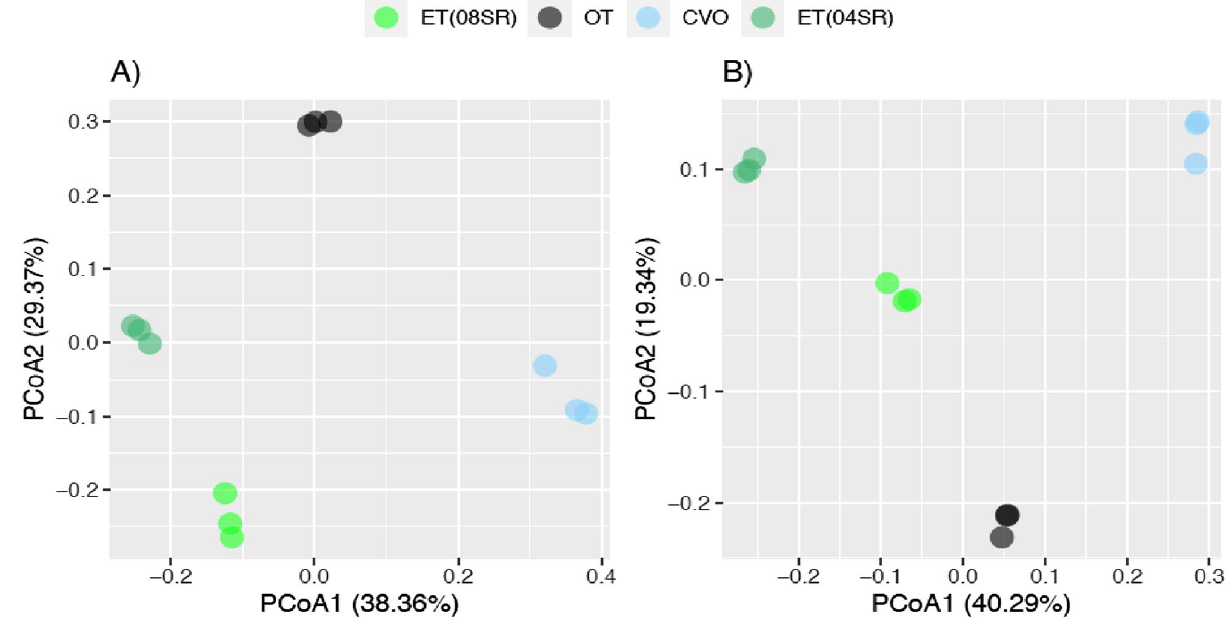
Figure 1. The Principal Coordinates Analysis (PCoA) of shallow alkaline lakes. The letter ( A ) corresponds to the dry season, while the letter ( B ) corresponds to the wet